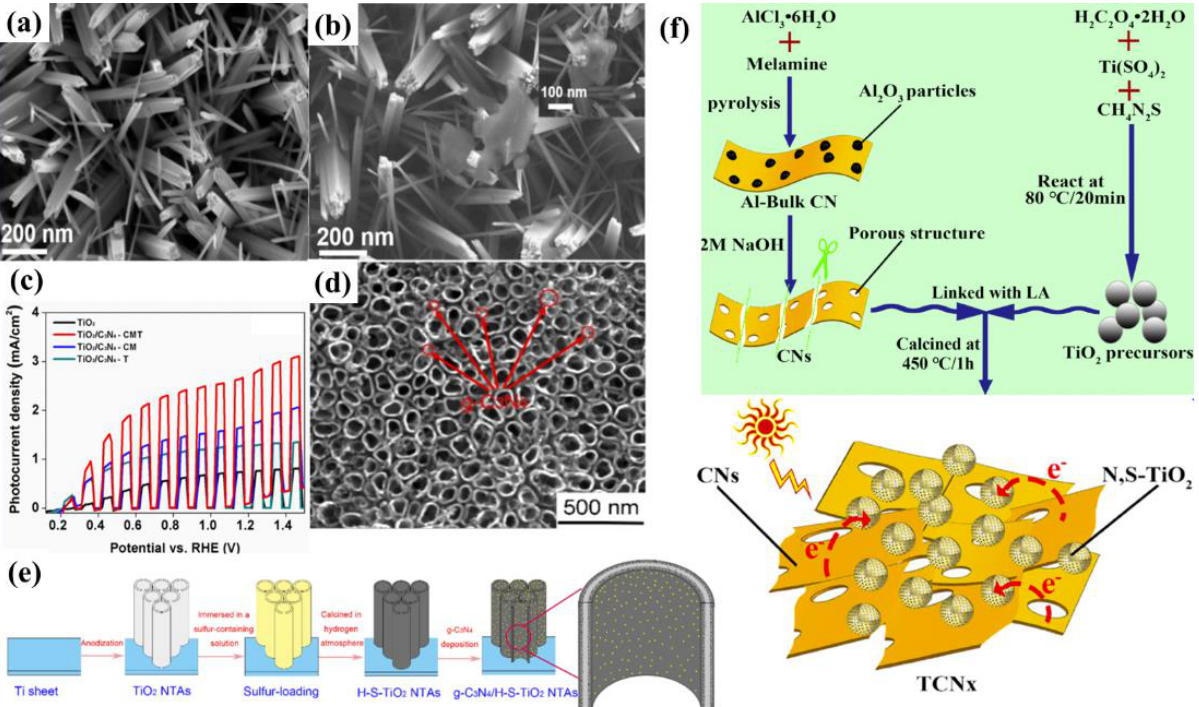
Figure 18. FE-SEM images of ( a ) pure TiO 2 , ( b ) TiO 2 / g−CN− CMT. ( c ) LSV photocurrent density in 1MNaOH at 1.23 V vs. RHE. Reprinted with permission from ref. [175] Copyright 2020 Elsevier. Top-view SEM images of ( d ) g−CN /H-S − TiO 2 NTAs4. ( e ) Schematic illustration of fabrication progress. Reprinted with permission from ref. [178] Copyright 2020 American Chemical Society. ( f ) Schematic illustration of the preparation. Reprinted with permission from ref. [179] Copyright 2021 Elsevier.